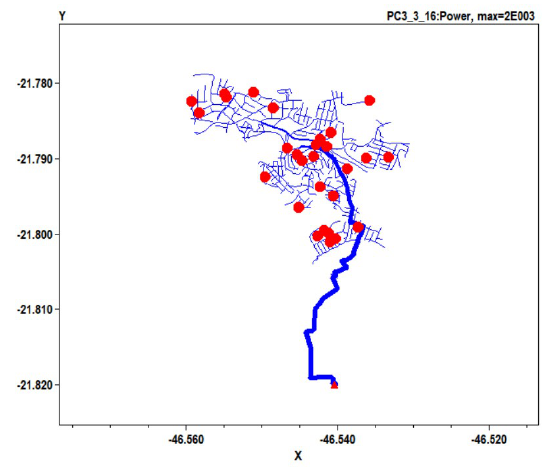
Figure 5. Location of 25% of the 45kVA